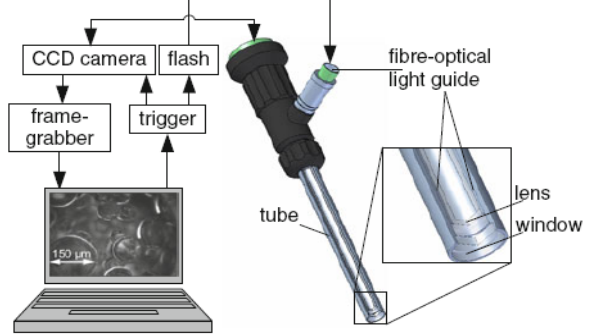
Figure 9. 3D drawing of the endoscope probe and general set-up [99]. A strobe flash is vicinity of the